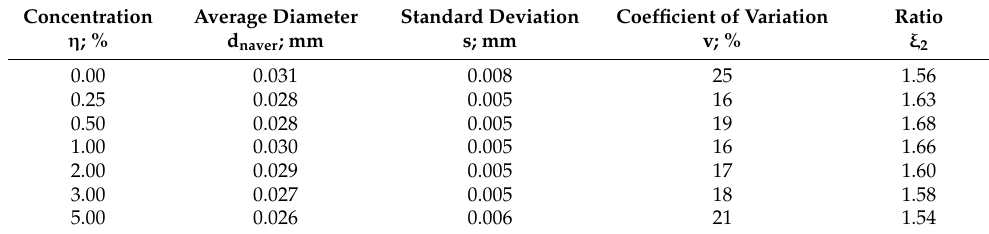
Table 8. Characteristics of the nodes’ diameters.